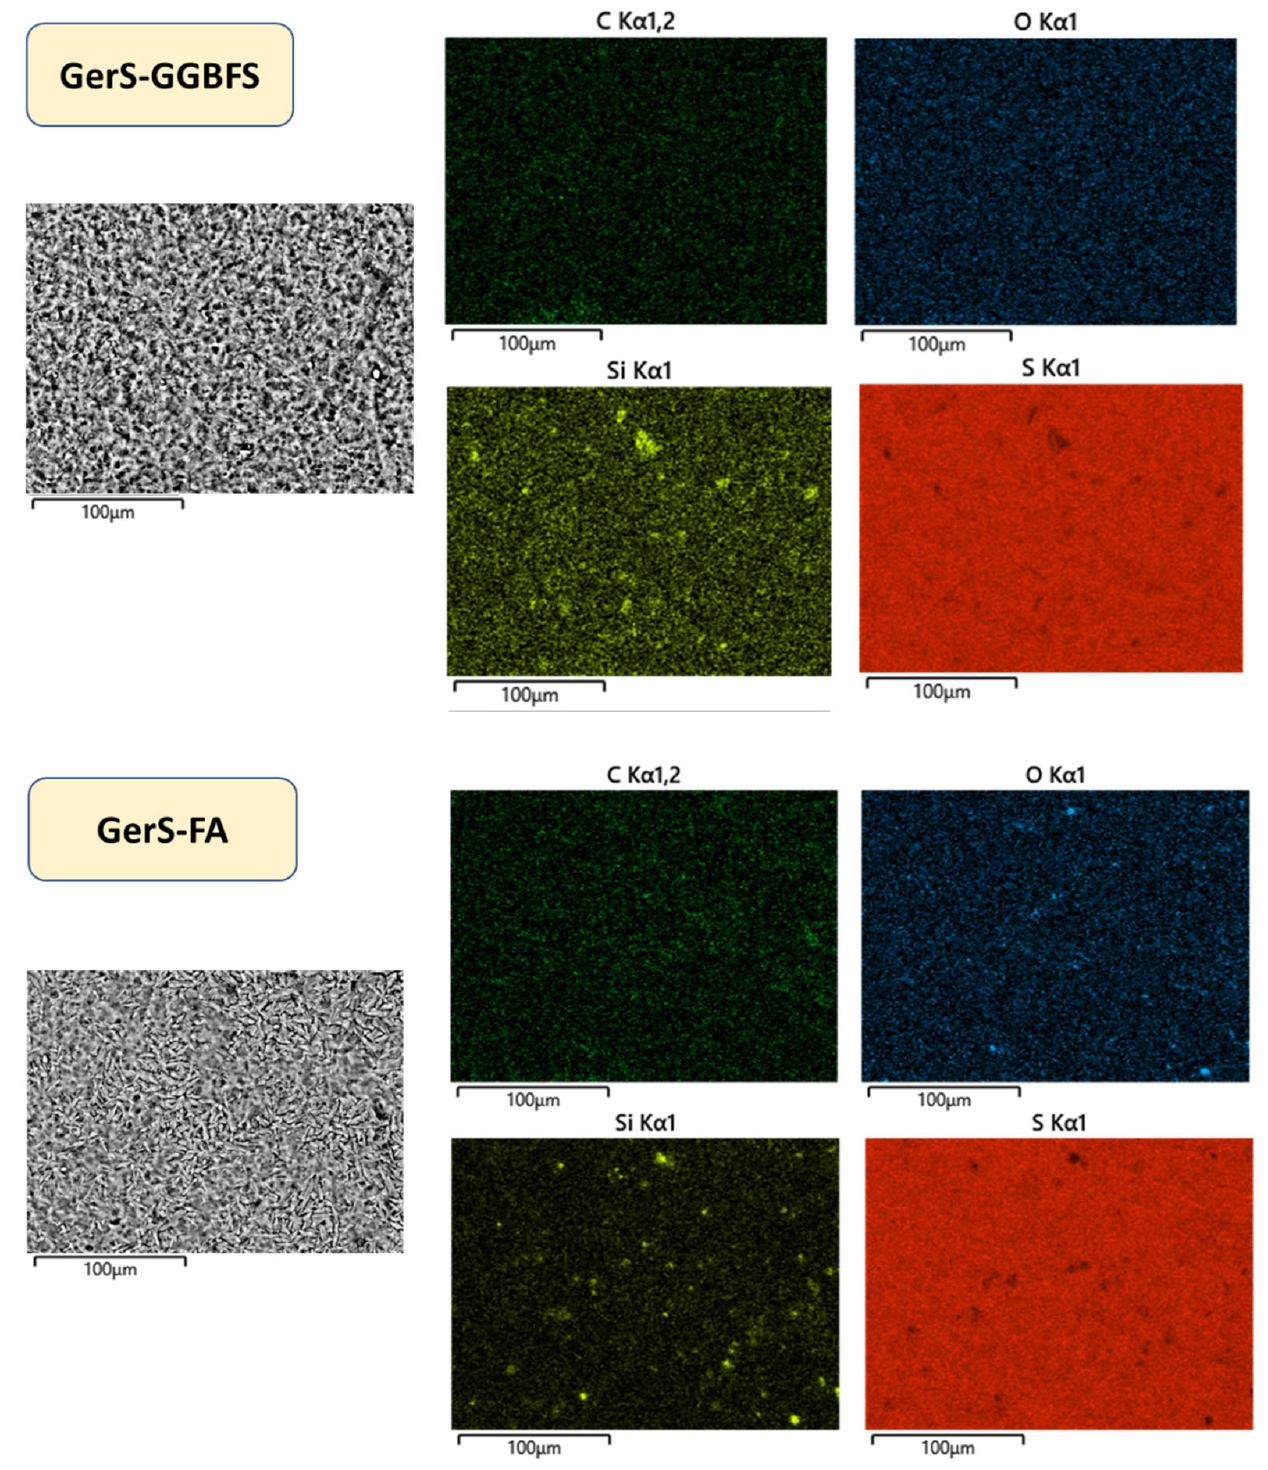
Figure 2. SEM/EDX data for composites reveals the presence of mineral additive well-dispersed in the homogeneous GerS binder for the GerS-derived materials.